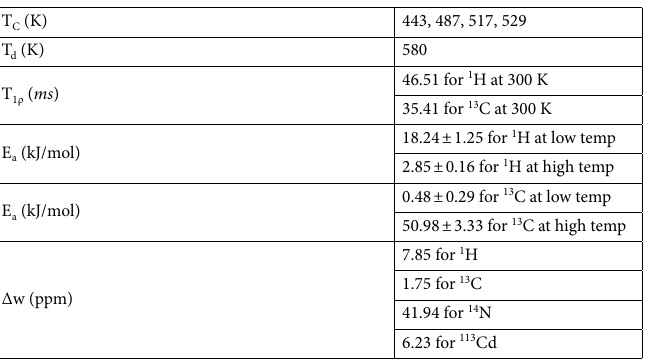
Table 3. Phase transition temperature, T C , decomposition temperature, T d , spin–lattice relaxation time, T 1ρ , and activation energy,